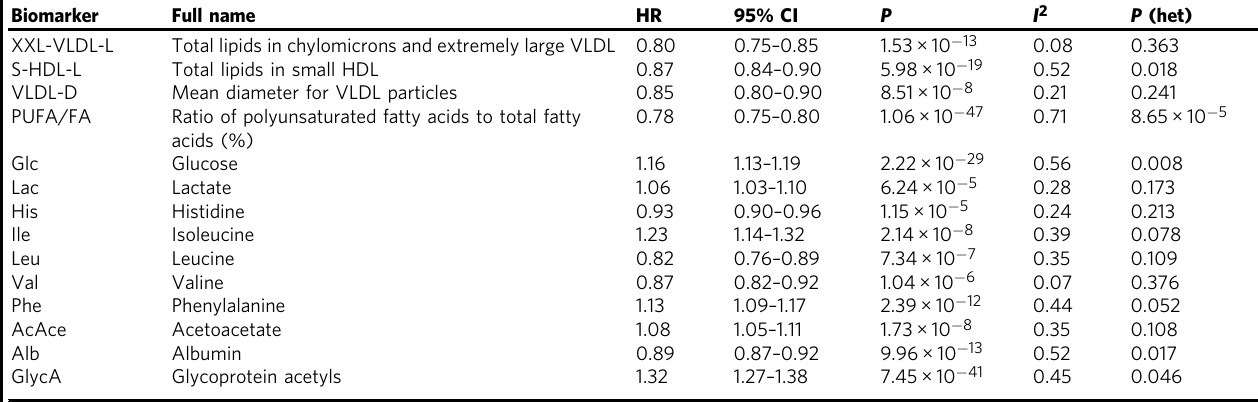
Table 2 Association of the 14 identi fi ed metabolic biomarkers with all-cause mortality in the fully adjusted model Biomarker